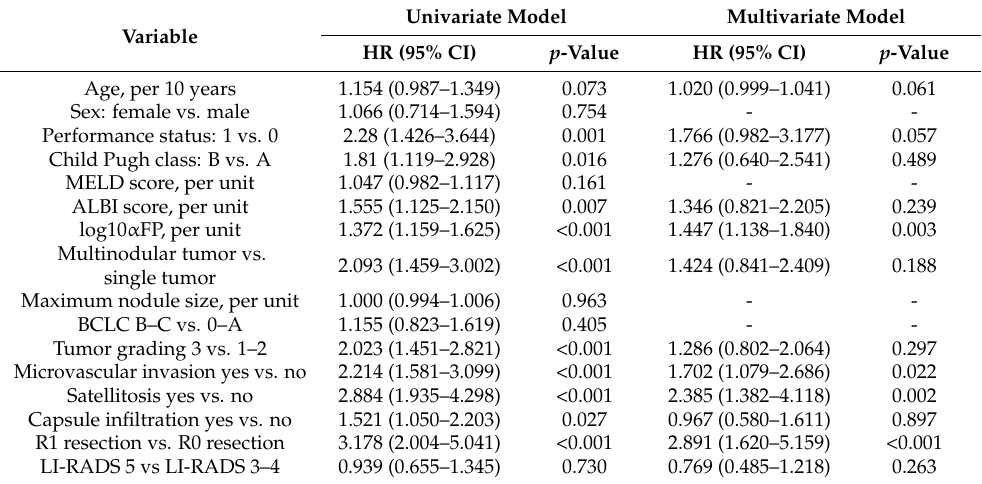
Table 3. Univariate and multivariate association of risk factors with relapse-free survival by Cox regression.